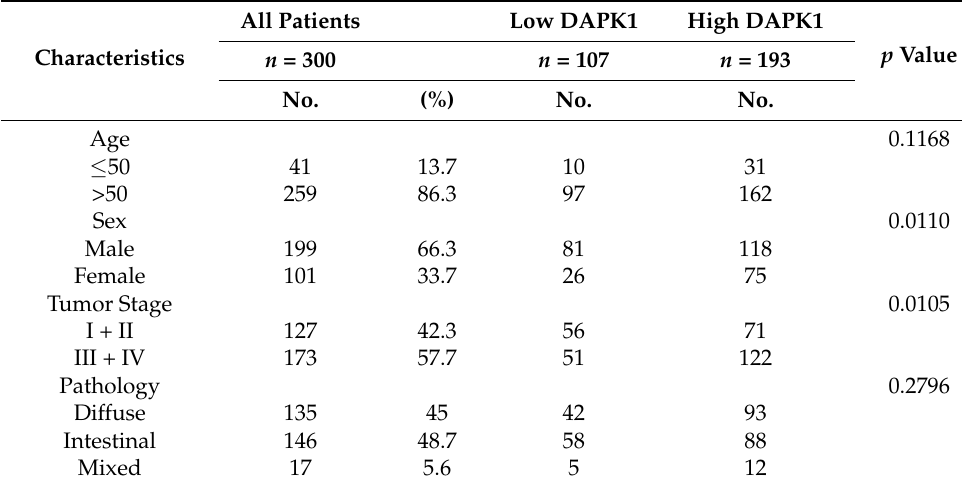
Table 1. Characteristics of GC patients and DAPK1 level based on GSE62254 dataset.